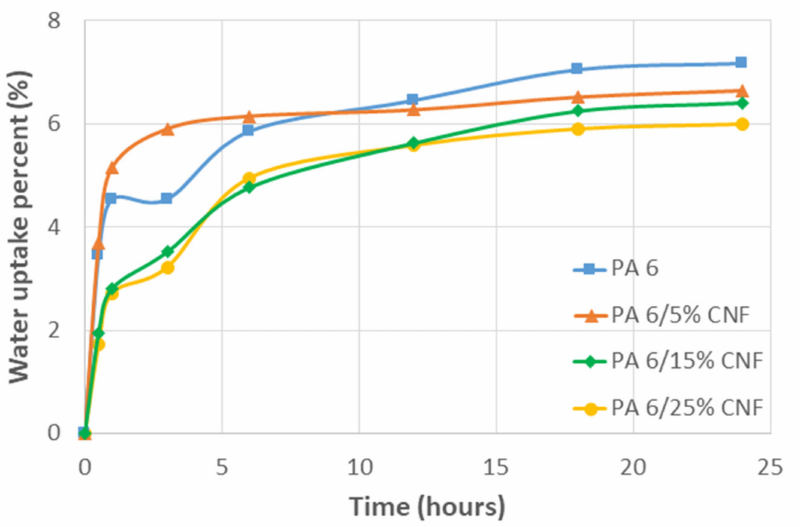
Figure 5. Water absorption percent versus time for neat PA 6 and PA 6/CNF nanocomposites at room